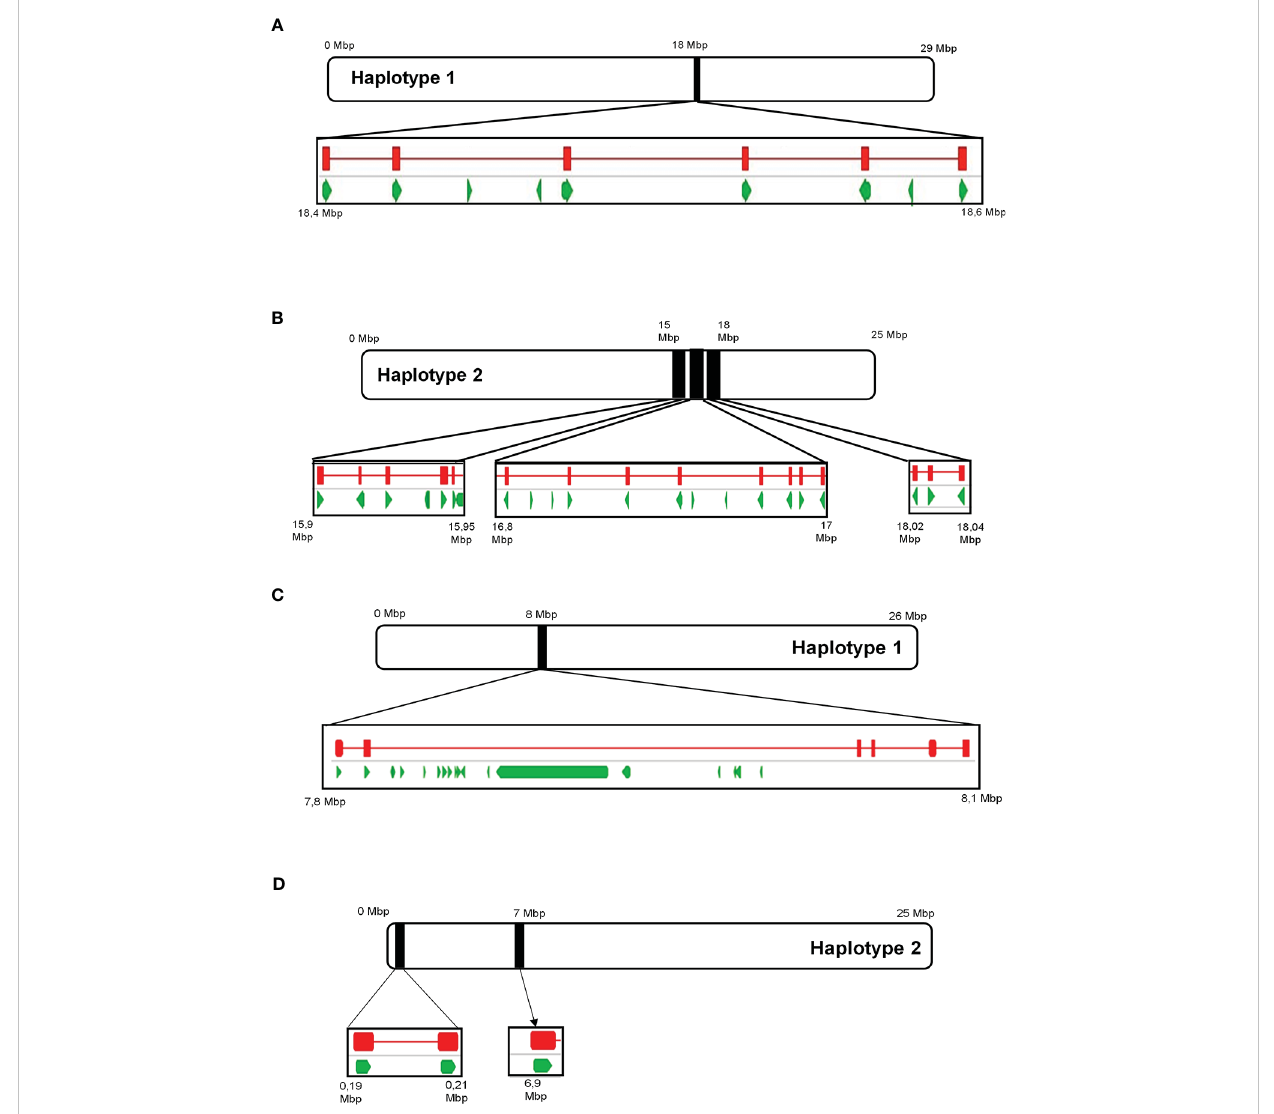
FIGURE 9 The position of predicted ‘ Cabernet Sauvignon ’ VvTer and VvGer genes on chromosome 13 (A, B) and chromosome 12 (C, D) , respectively. Black blocks indicate the position of the predicted VvTer or VvGer clusters on the chromosomes, and squares underneath provide a magni fi ed view of the region. Green arrows represent predicted genes as annotated in Massonnet et al. (2020), while red lines indicate the position of BLAST hits for VvTer or VvGer